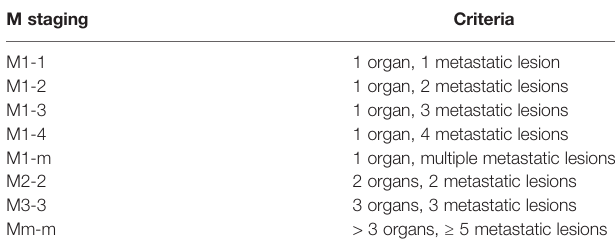
TABLE 1 | Multilevel subdivision of M